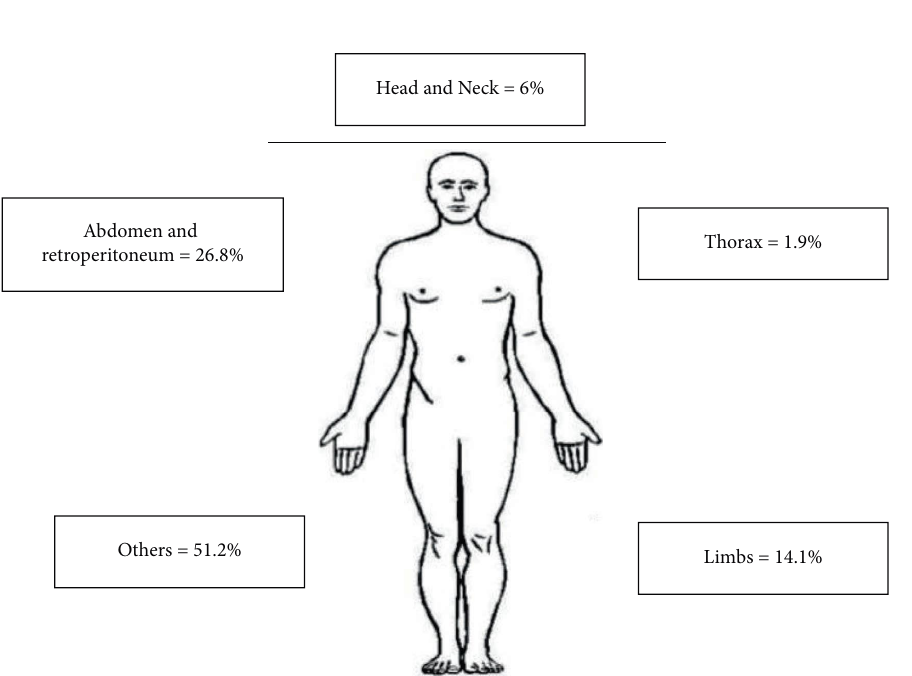
Figure 2: Anatomical location of